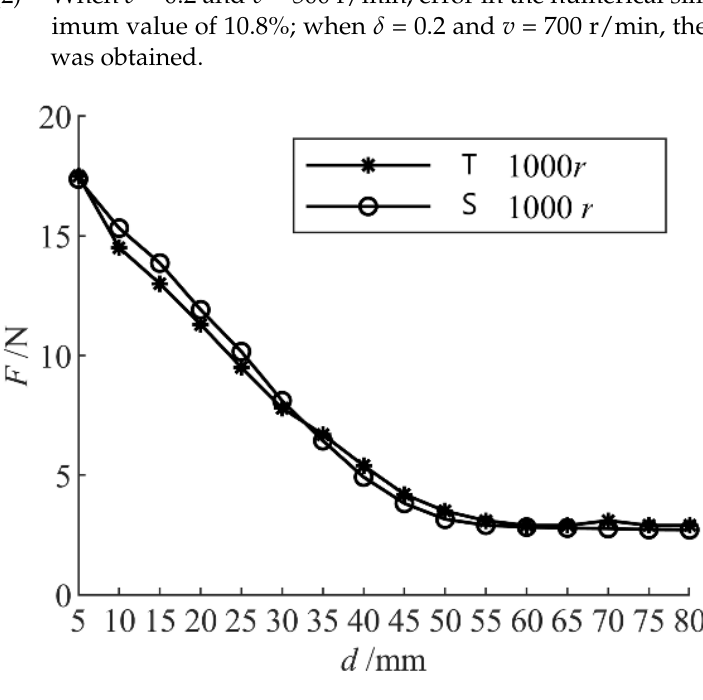
Figure 22. F- d ( v = 1000 r/min, δ = 0.2).